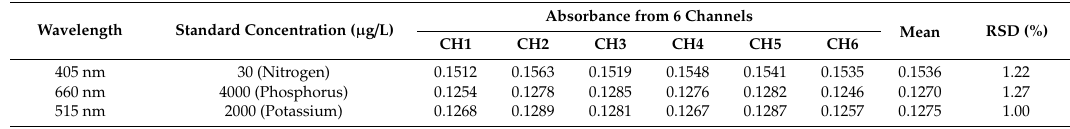
Table 1. Results of absorbance uncertainty obtained from 6